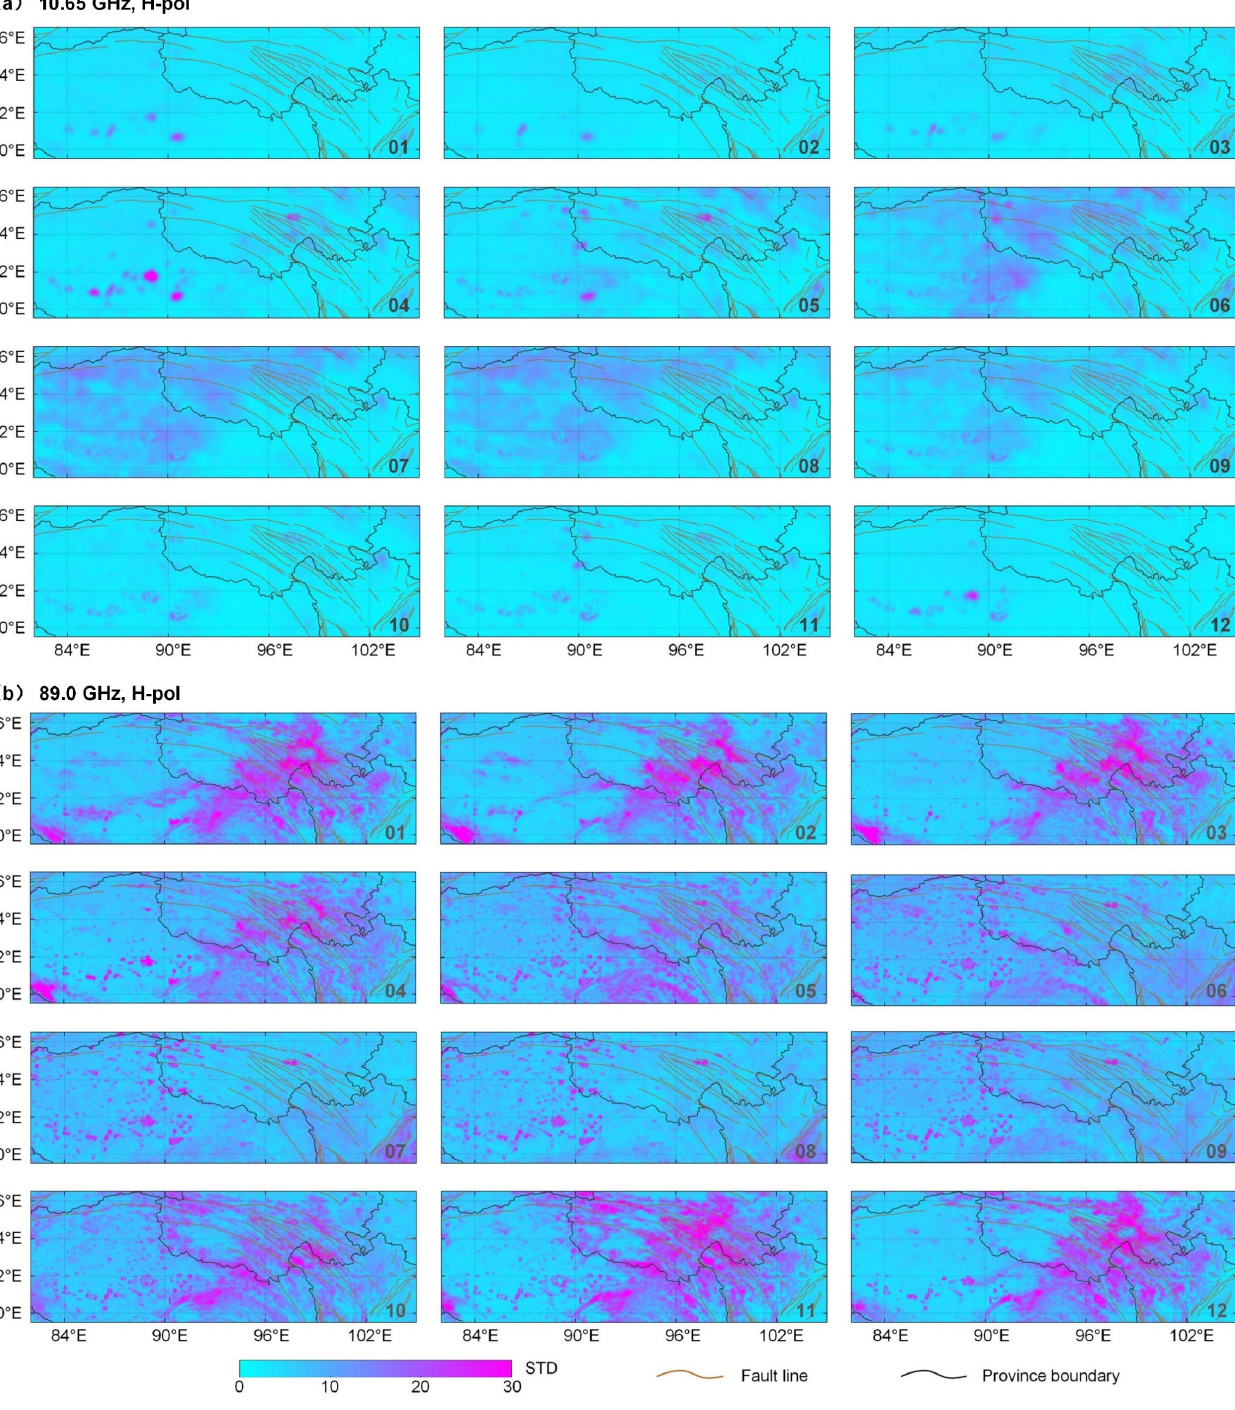
Figure 3. Monthly STD of MBT in the Bayan Har block and its surrounding area at 10.65 GHz ( a ) and 89.0 GHz ( b ) with H-pol (from January to December). The calculation was based on MBT data from the same month in different years.